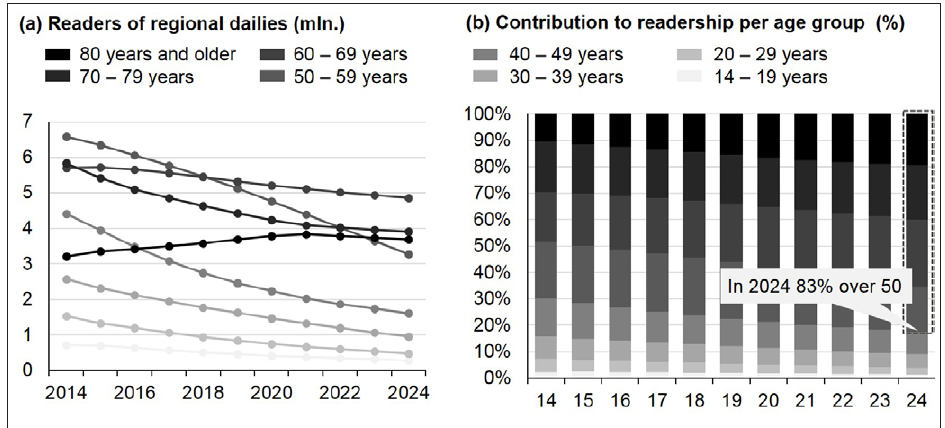
Figure 8: Modelling newspaper readership per age group as well as in absolute numbers for regional newspapers. Source : Own elaboration based on model